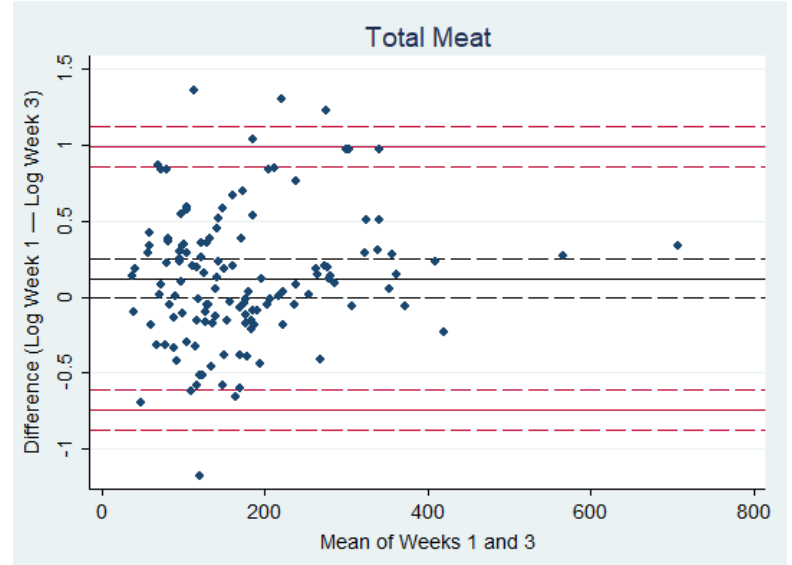
Figure 2. Bland-Altman plot for total meat (g/day) showing the comparability of weeks 1 and 3 of the Oxford Meat Frequency Questionnaire. Measurements of meat intake after log transformation of difference data plotted against original mean data. Limits of Agreement are shown as solid red lines with 95% confidence intervals (dashed lines). The mean difference (bias) is shown as the solid black line with 95% confidence intervals (dashed lines). The mean difference (bias) data is on a log scale and so is equivalent to a ratio on a linear scale.